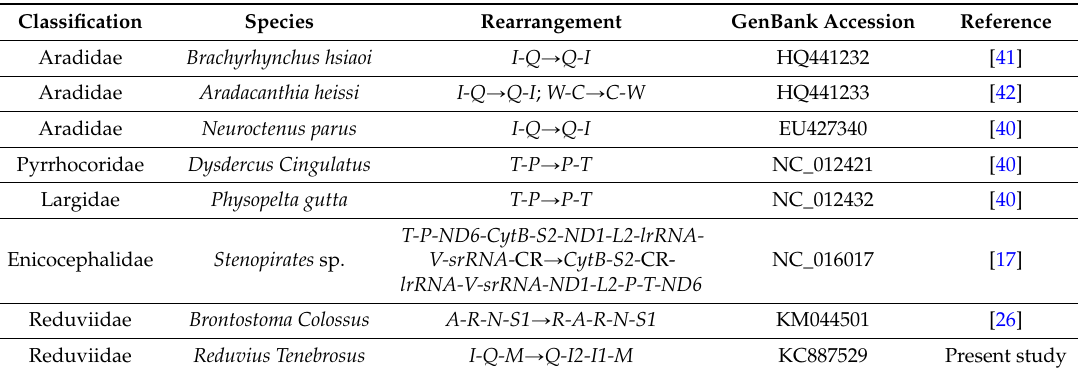
Table 1. Mitochondrial gene rearrangements in true bug mt genomes.